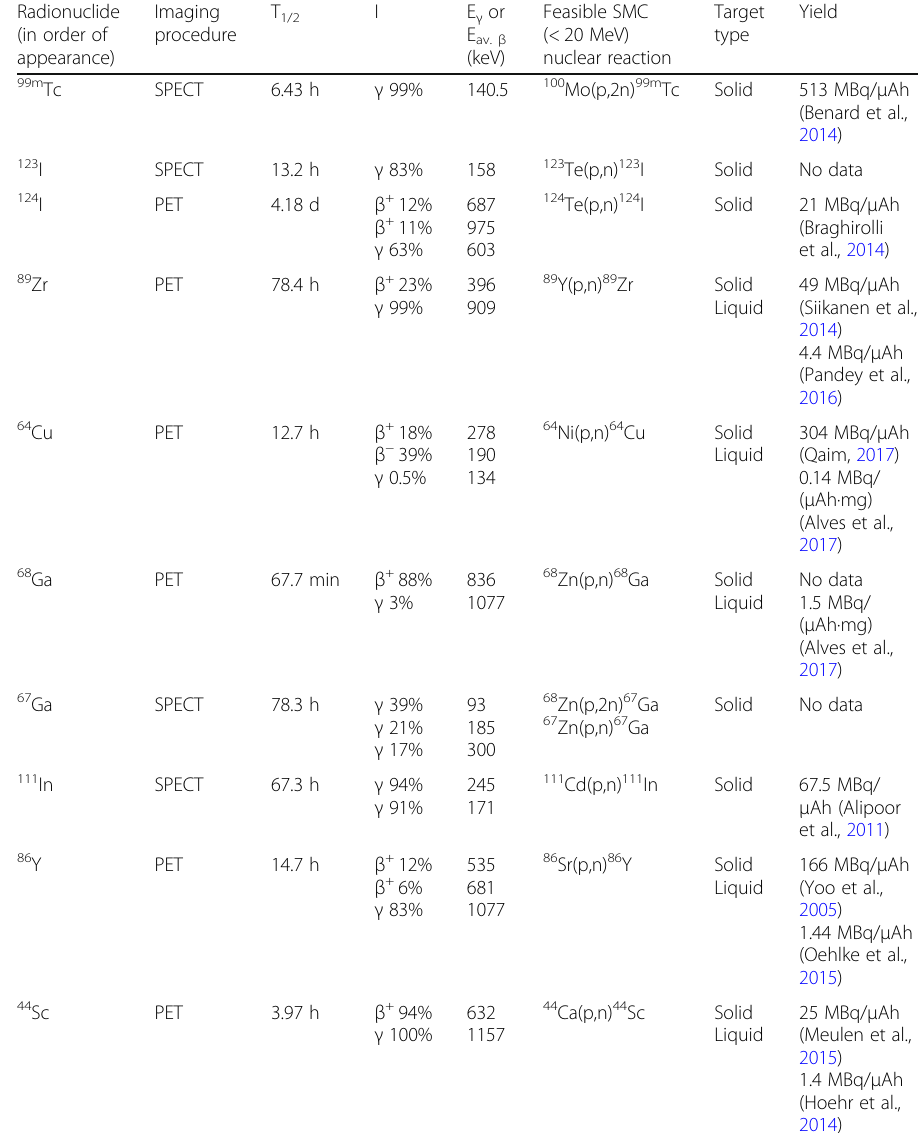
Table 4 Comparison of the properties of presented radionuclides Radionuclide (in order